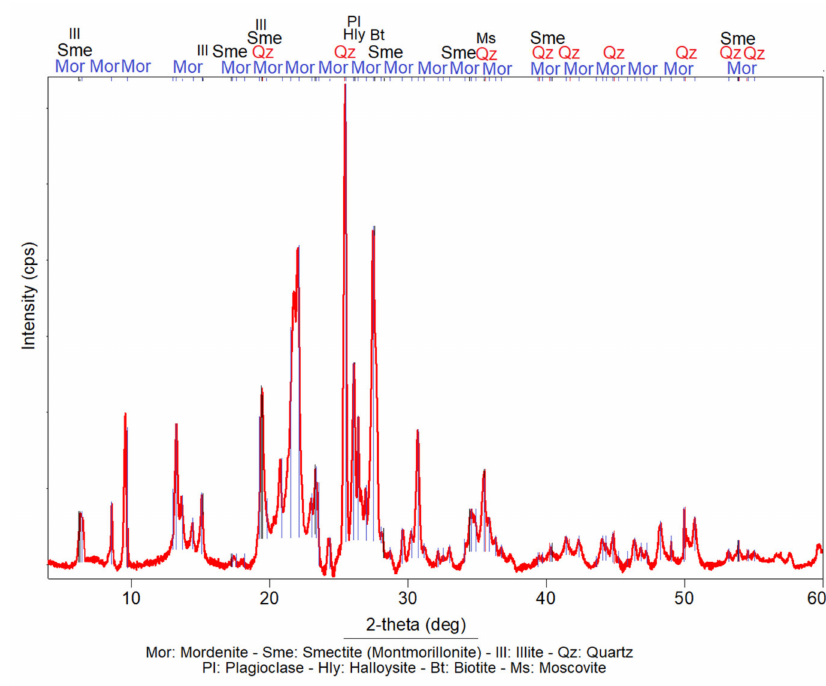
Figure 1. X-ray diffraction patterns obtained from the analysed sample. The reflections of quartz peaks are observed in several angular positions (2 θ ). The authors only highlighted peaks of greater intensity. The peak of highest intensity (Imax: 100%) was located at position 2 θ : 26.54. Other peaks of medium intensity were located at the following 2 θ positions: 20.76, 36.45, 39.36, 40.19, 42.35, 45.70, 50.05, 54.79 and 55.23. Illite has its main peak at position 2 θ : 8.81 with a relative intensity between 37 and 90%. Other secondary peaks are located at positions 2 θ : 9.0, 26.88, 28.11, 35.62, 45.67 and 55.06, with intensities that vary between 1.56 and